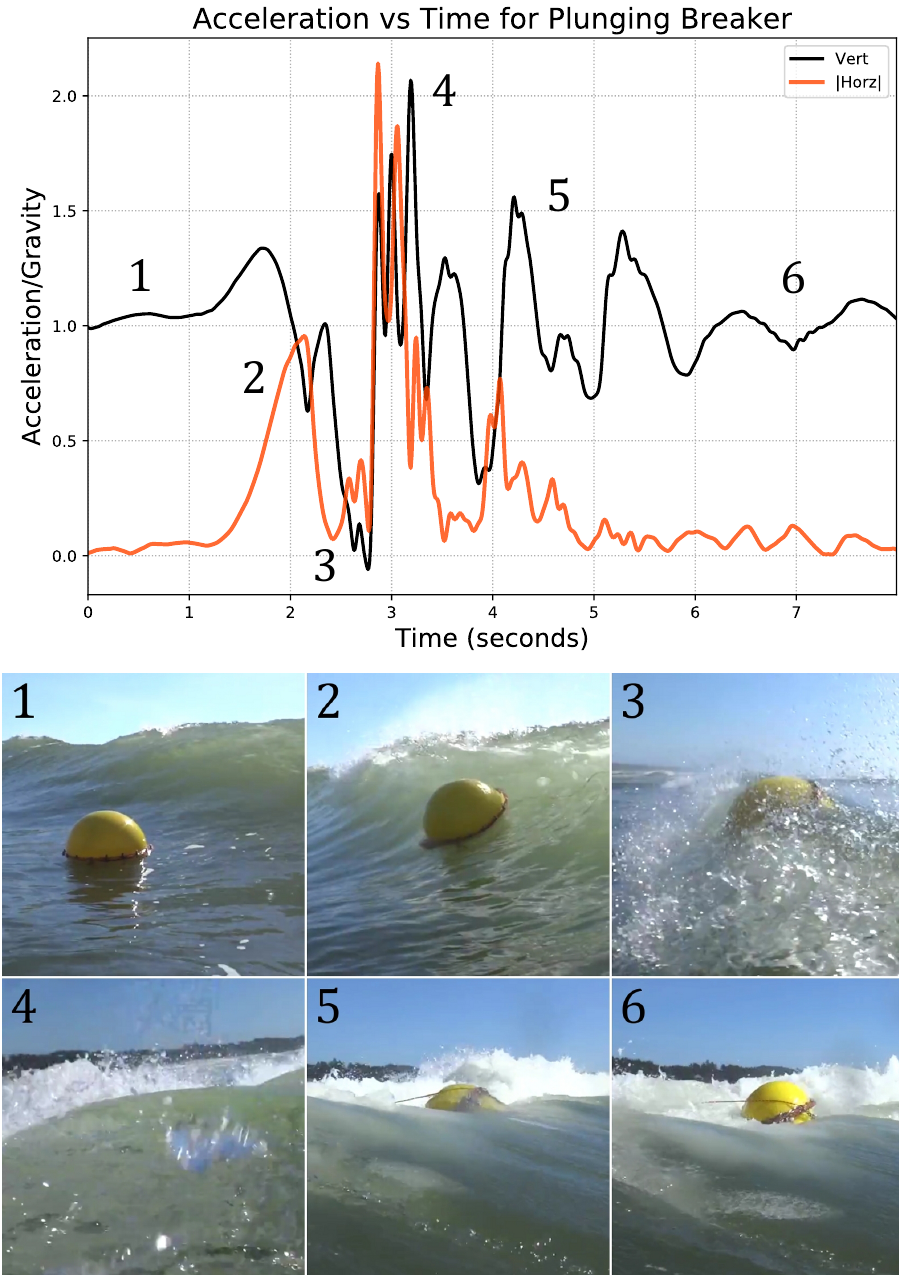
Figure 8. A sequence of screen captures from the video of a plunging wave impact. The buoy is shown: ( 1 ) floating in the preceding wave trough, ( 2 ) rising vertically on the front face of the wave, ( 3 ) entering the plunging jet, ( 4 ) falling forward of the wave, ( 5 ) emerging from the wave as it transitions to spilling, and ( 6 ) regaining equilibrium in the waves wash. Wave recorded on 10 April 2014 at 16:10:41